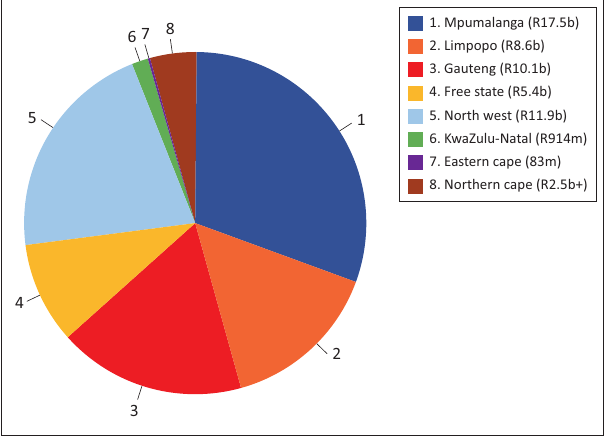
FIGURE 1: Financial provisions for rehabilitation in each province.